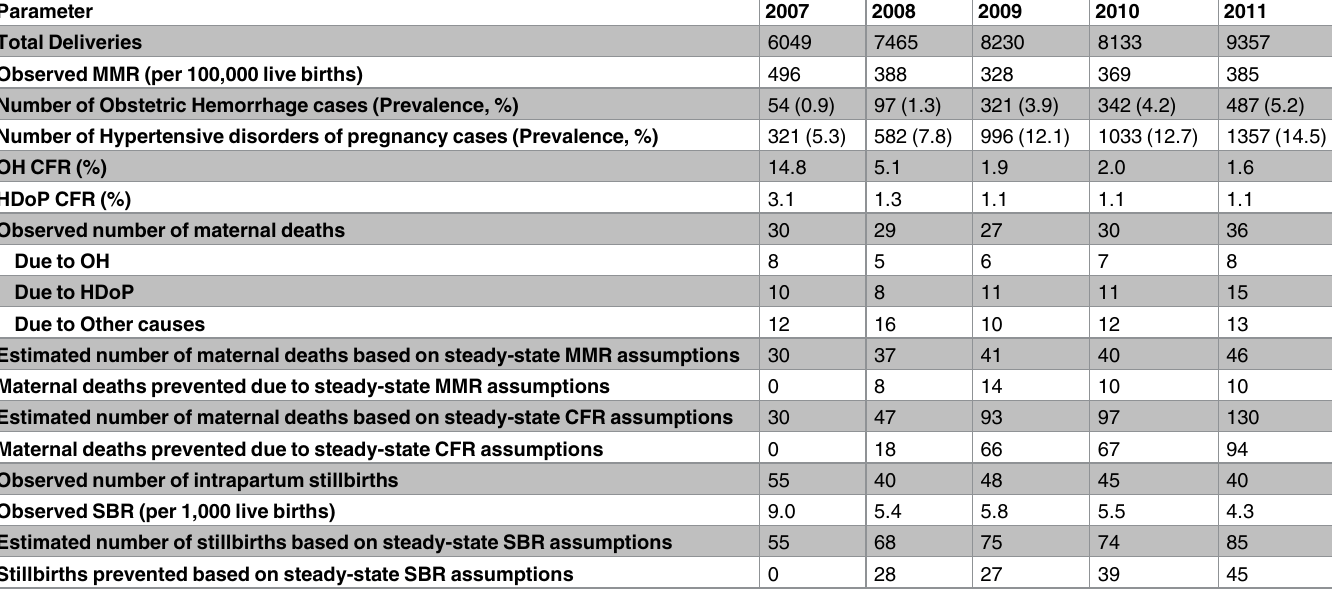
Table 3. Baseline data for the Kybele-GHS